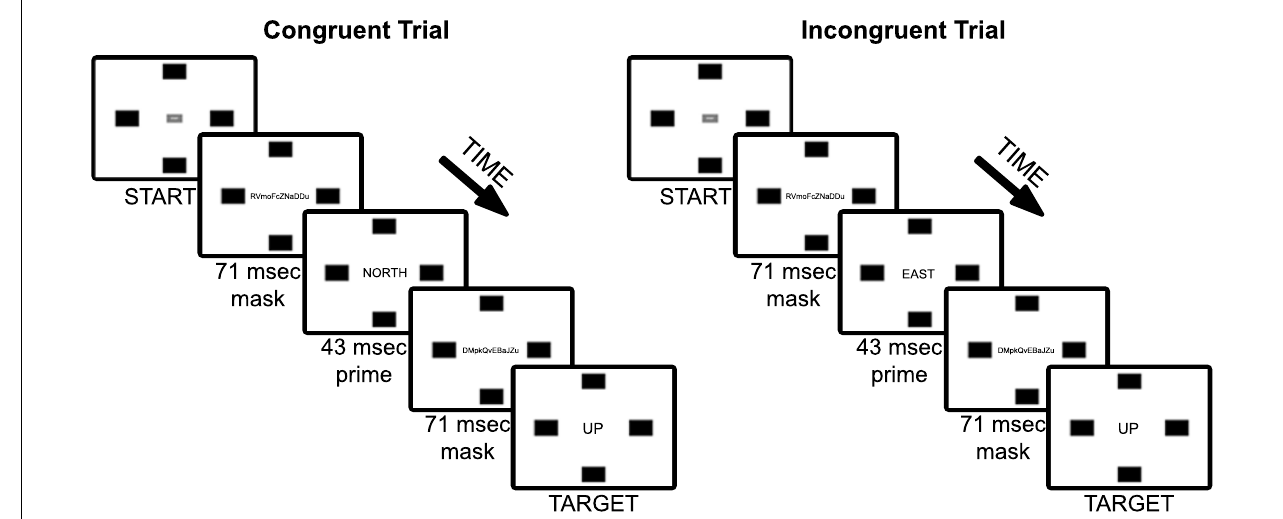
FIGURE 4 | Experiment 2 trial sequence of example congruent and incongruent (90˚) trial types. Note that font sizes of masks and primes, and drawn size of arrow, are increased for figure legibility.